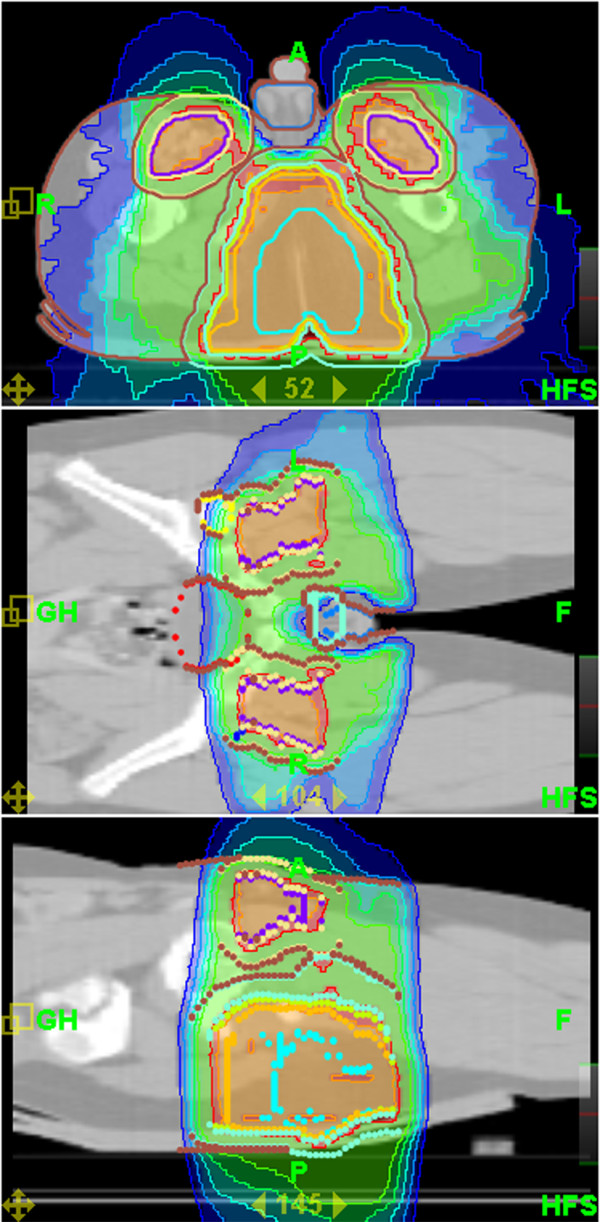
Dose distribution for perineal rhabdomyosarcoma.